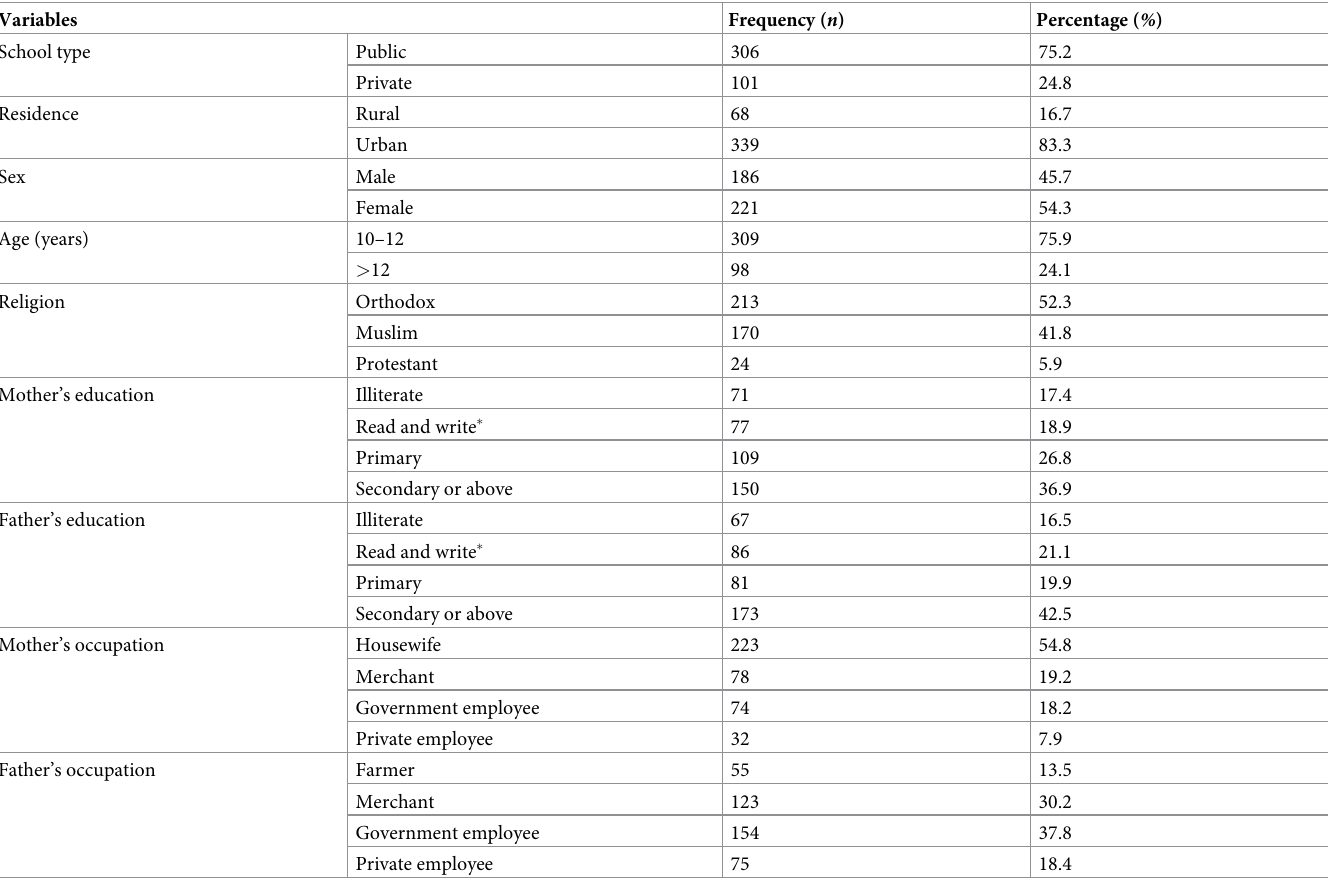
Table 1. Socio-demographic characteristics of Grades 4–8 primary school children, Dessie City, Ethiopia, April to June 2018. Variables Frequency ( n ) Percentage ( %